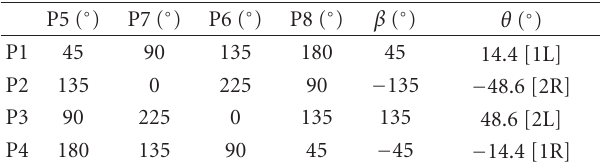
Table 1: Output phase di ff erence and estimated direction of generated